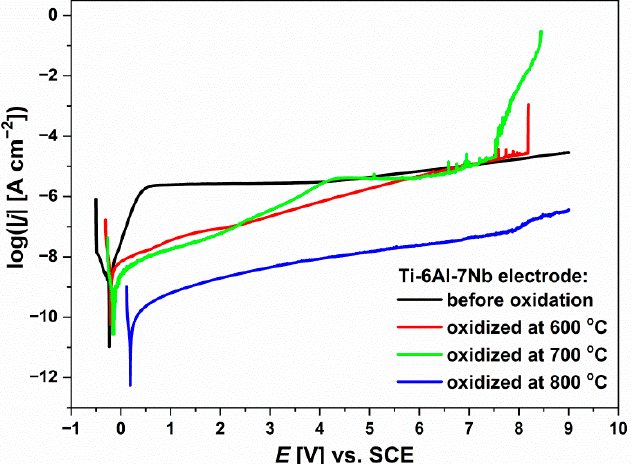
Figure 9. Anodic polarization curves for the Ti-6Al-7Nb electrode at the initial state and after isothermal oxidation at 600, 700, and 800 °C in saline solution at 37 °C.